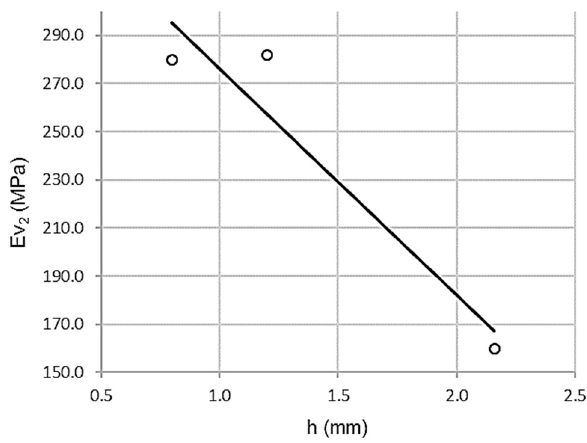
Figure 7. Scatterplot for wheel-tracking test and second modulus of the plate bearing test ( Φ 762 mm).